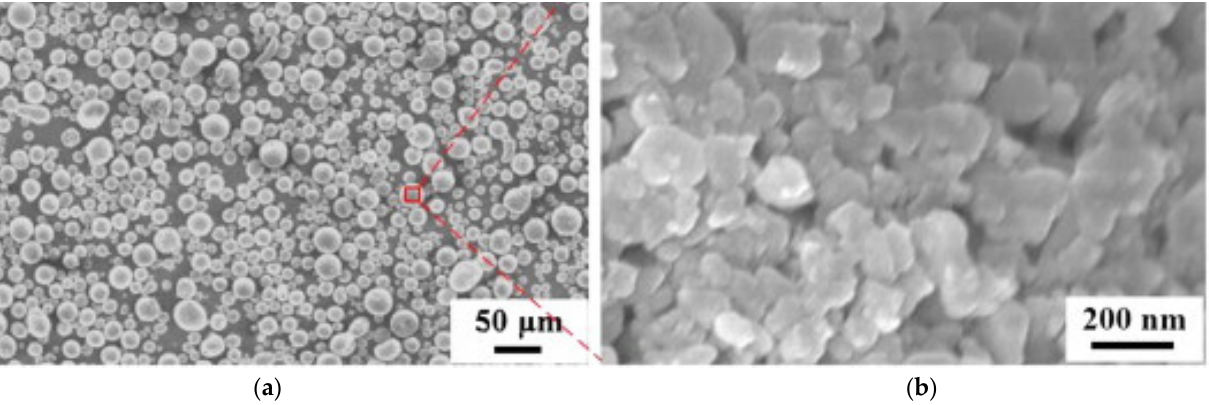
Figure 25. SEM micrographs of the plasma-treated spray-dried Al 2 O 3 –13 wt.%TiO 2 powders: ( a ) overall morphology, ( b ) high magnification surface morphology. Reprinted with permission from [134]. Copyright 2012 Elsevier.